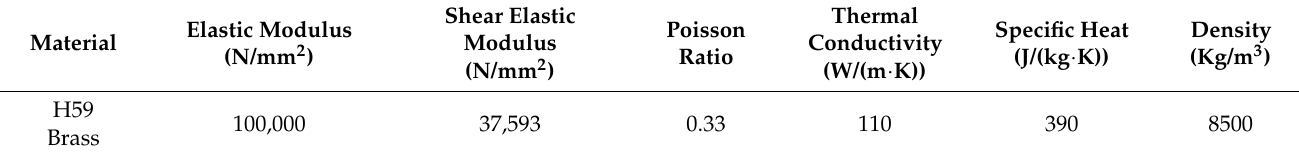
Table 2. Workpiece material properties.